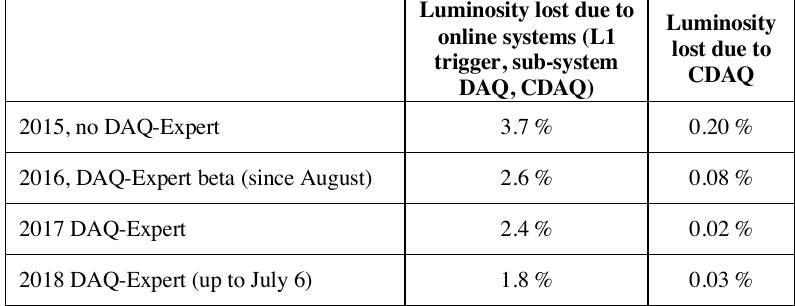
Table 1. Luminosity lost in down time events from 2015 to 2018 for down-time events caused by any online system (including CDAQ) and down-time events caused by CDAQ. Periods with zero trigger rate for > 30 seconds are considered as down time. Shorter interruptions of data-taking are counted as dead time. Luminosity lost due to infrastructure problems, tests, commissioning and due to dead time is not shown. The latter amounts to a similar amount as the luminosity lost due to down time. Luminosity lost due to Luminosity online systems (L1 lost due to trigger, sub-system CDAQ DAQ, CDAQ) 2015, no DAQ-Expert 3.7 % 0.20 % 2016, DAQ-Expert beta (since August) 2.6 % 2017